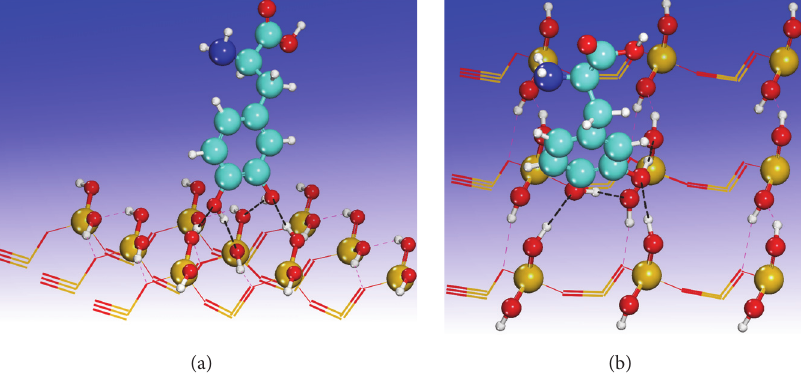
Figure 2: Side view (a) and top view (b) of dopa molecule adsorbed on geminal silica surface with intermolecular distances of 1.85 ˚A.